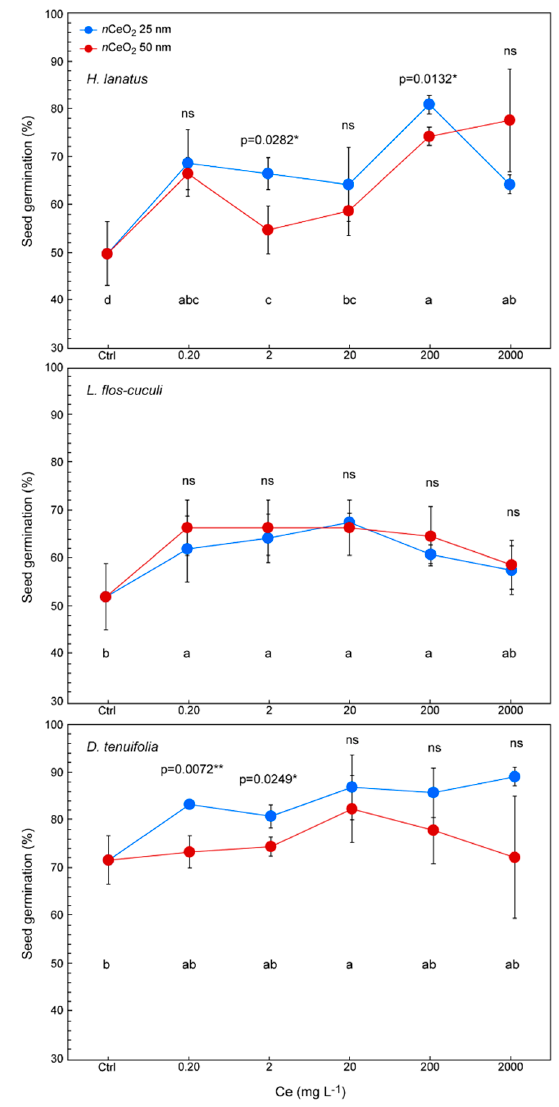
Figure 3. Percentage of seed germination in H. lanatus , L. flos-cuculi and D. tenuifolia , grown in Petri dishes and treated with solutions of n CeO 2 25 nm and n CeO 2 50 nm at 0, 2, 20, 200 and 2000 mg L − 1 , respectively. The values are mean ± SD (standard deviation) of 3 replicates. Statistical significance of the treatments for each Ce concentration is reported: (i) figure upper part → comparison between n CeO 2 25 nm and 50 nm; (ii) figure lower part → comparison between all treatments. Di ff erent letters indicate statistical di ff erences. ns = not significant, * p ≤ 0.05, ** p ≤ 0.01.